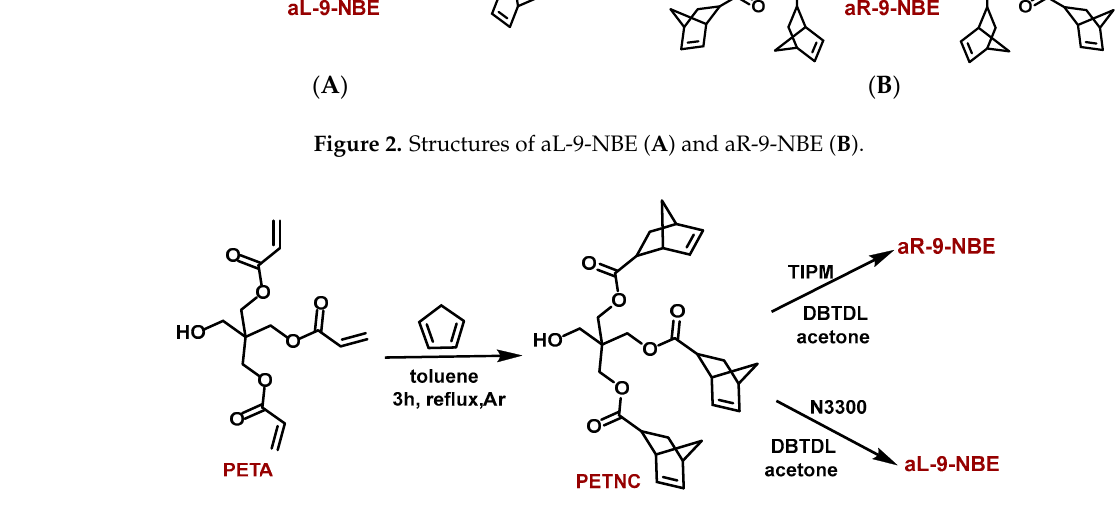
Scheme 2. Synthesis of dendritic monomers.